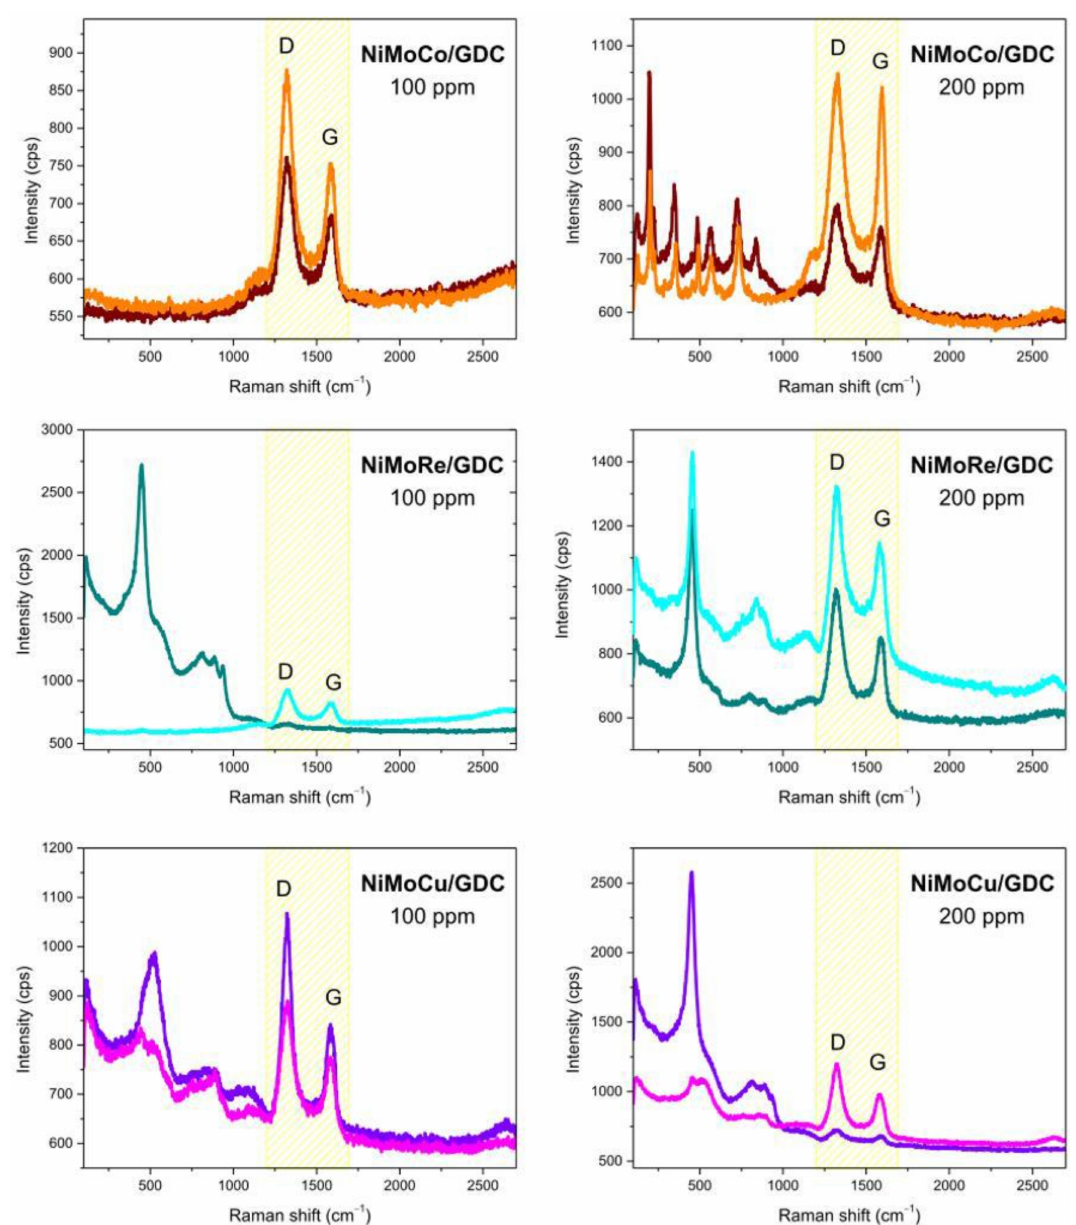
Figure 12. Micro-Raman spectra of the exhaust catalysts after ATR of ethanol at 800 ◦ C with different H 2 S concentrations, as-measured in two different locations of each specimen. Features arising from the C sp 2 related bands of deposited carbon are